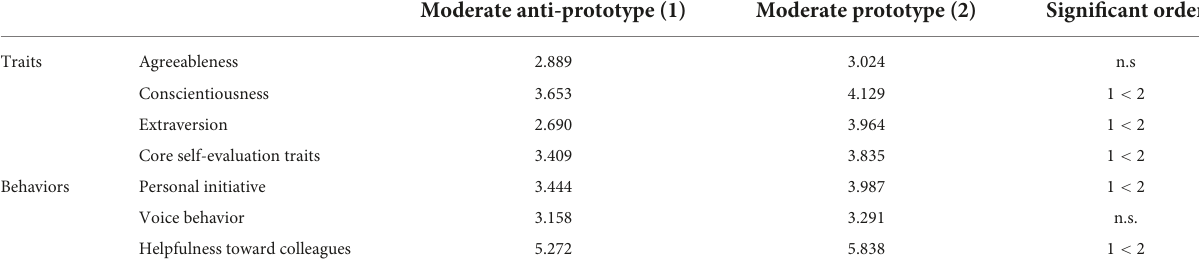
TABLE 6 Differences in means for traits and behaviors of the two latent profiles ( t 2